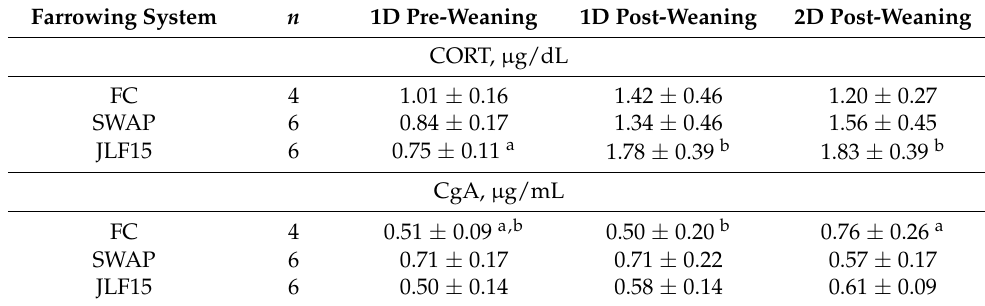
Table 5. Concentration of salivary cortisol (CORT) and chromogranin A (CgA) of piglets (mean ± SE) collected on D23 (1D pre-weaning), D25 (1D post-weaning) and D26 (2D post-weaning) in three far- rowing systems (FC: conventional farrowing crate; SWAP and JLF15: farrowing pens with temporary crating). Values with a different superscript ( a , b ) correspond to a significant difference ( p ≤ 0.05) between sampling days in the same farrowing system. n indicates the number of nursery